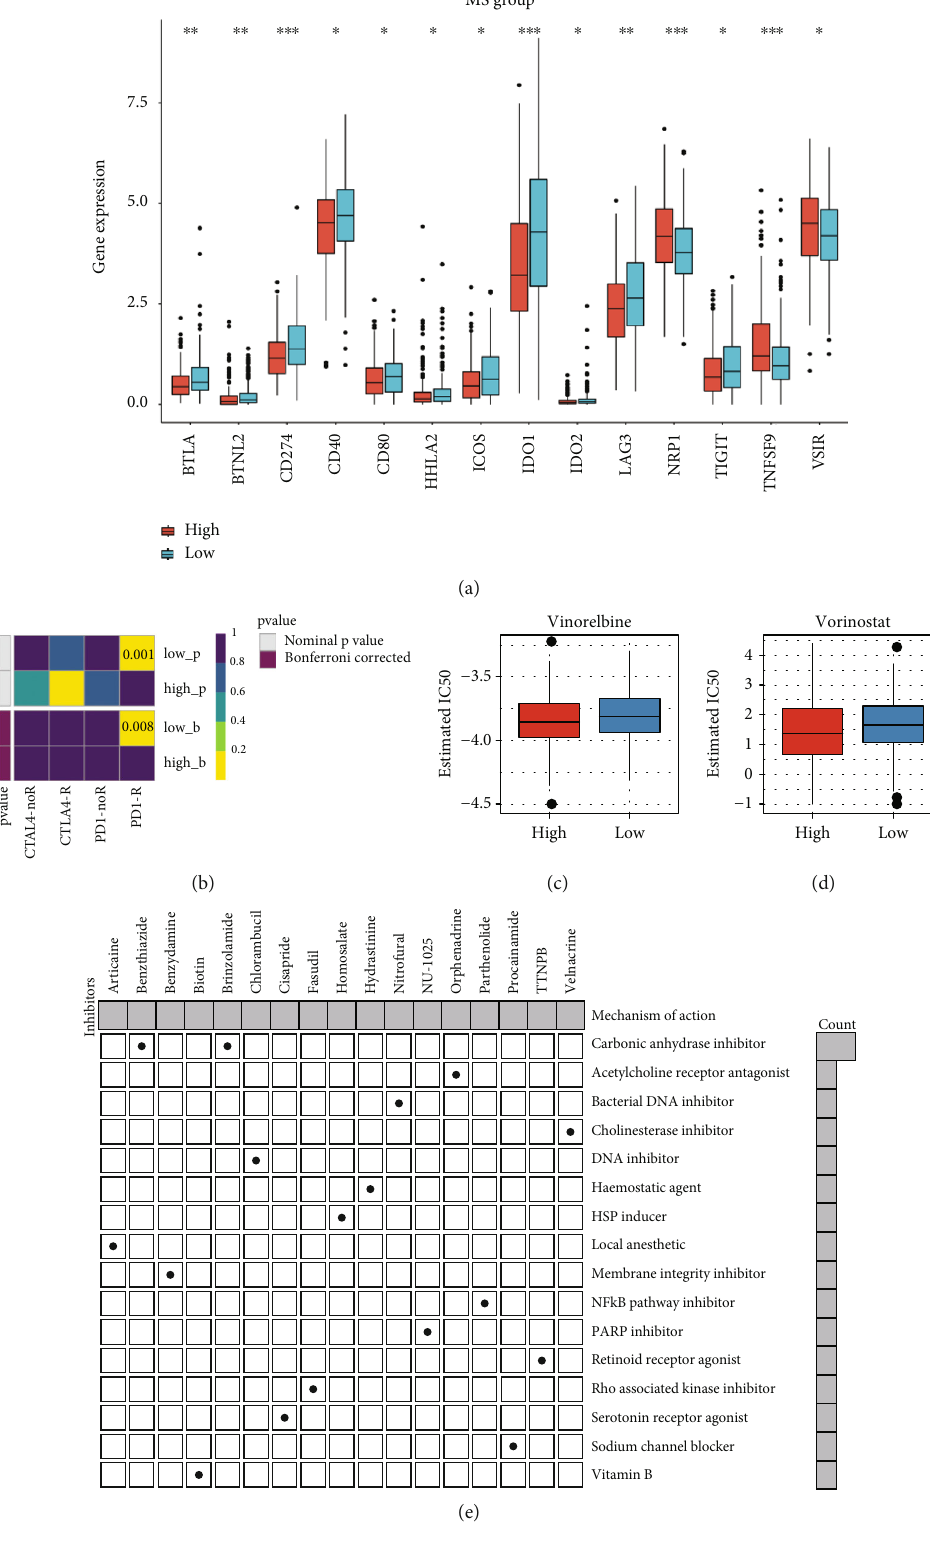
of vinorelbine in MS groups. (d) IC of vorinostat in MS 50 50